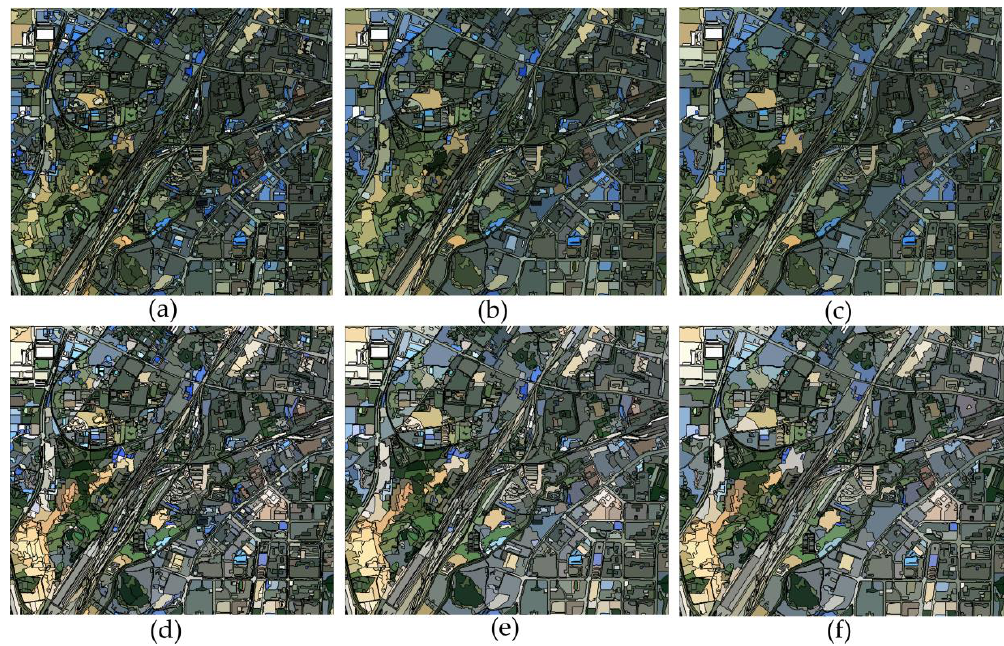
Figure 12. Mean object value maps for DS1 at different optimal scales. ( a – c ) Scales of 136, 206, and 244 for the image acquired on 13 April 2015; ( d – f ) Scales of 136, 206, and 244 for the image acquired on 11 May 2016.